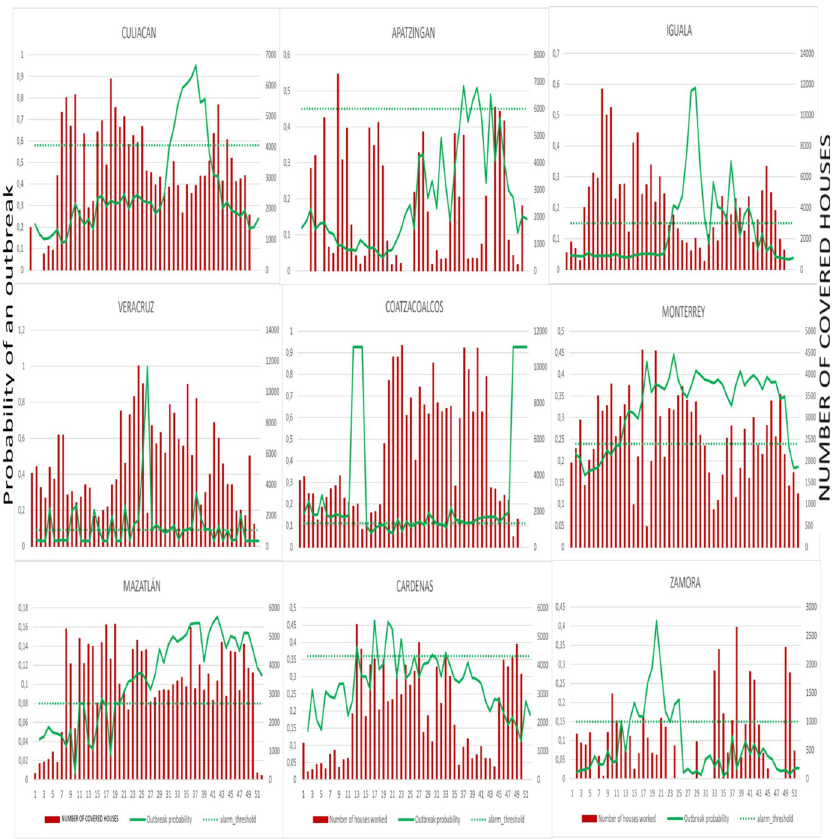
Fig 2. Time-series of weekly number of houses covered with larval control against the probability of outbreaks at before and after the alarm signals (week 28), in non-outbreak